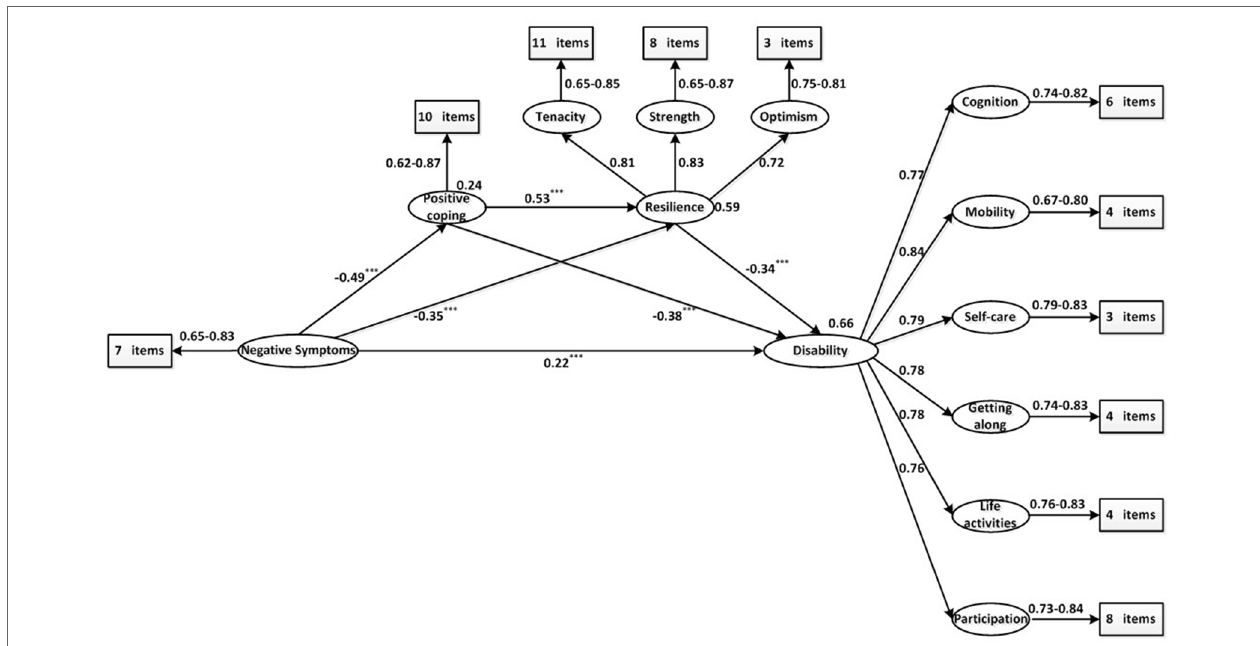
FIGURE 2 | Result of the proposed schizophrenia disability distal mediation model. The ellipses represent latent variables. The rectangles represent observed variables. All path coefficients are standardized. The squared multiple correlation (R 2 ) value for the dependent variable appears above the ellipses. *** p < 0.001.